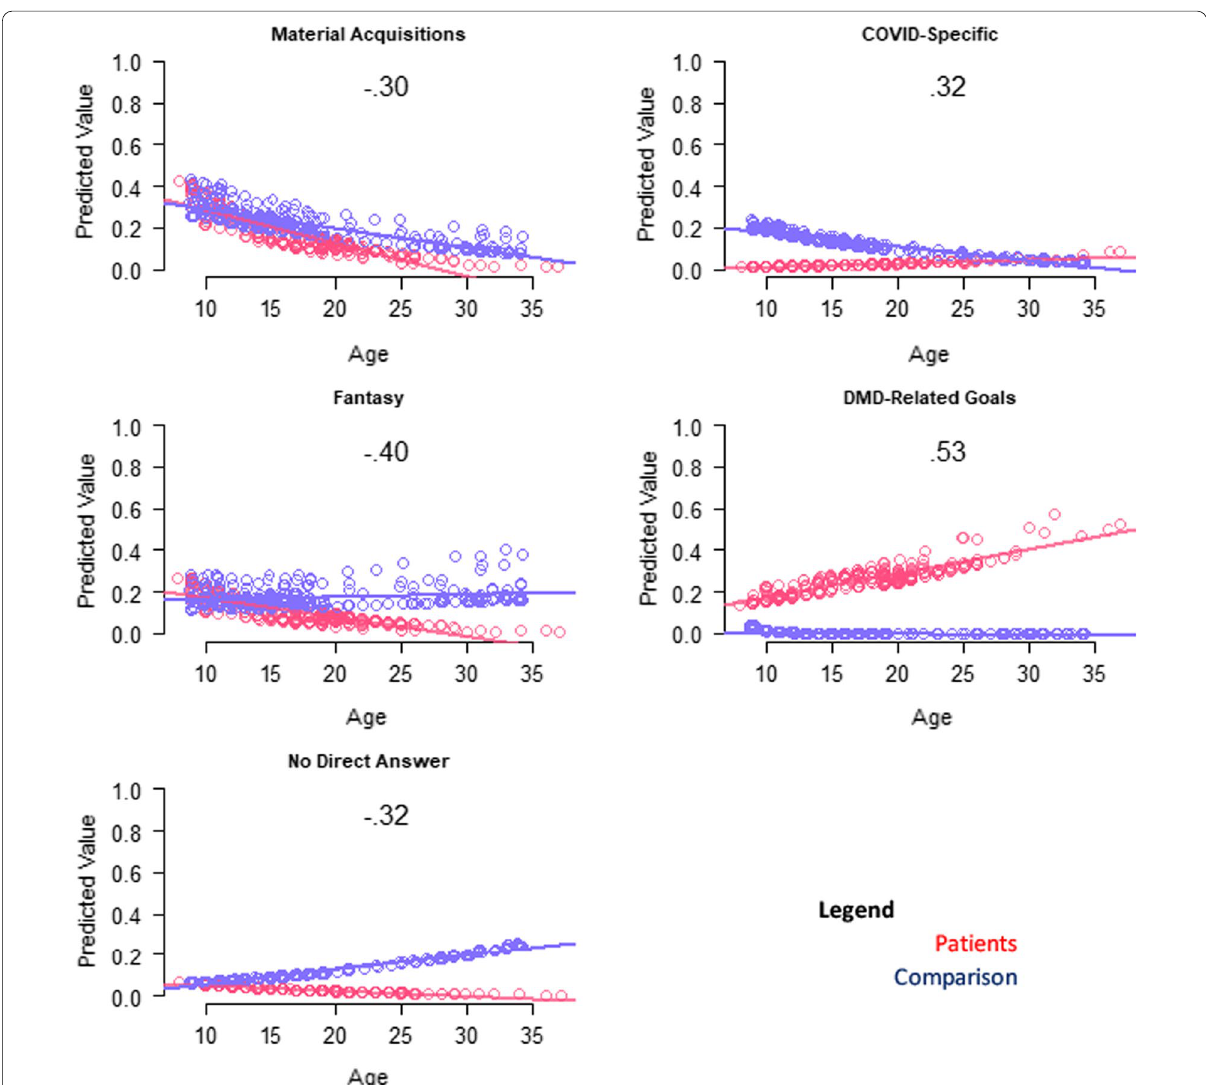
Fig. 2 Interaction plots for adjusted logistic models predicting wishes themes. Role-group differences for medium- and large-ES interaction effects are shown. Patient predicted values are shown in red; comparison in